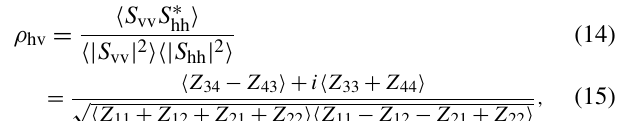
Figure 5. The co-polar correlation coefficient ρ hv as a function of rainfall rate R at multiple frequencies using the side